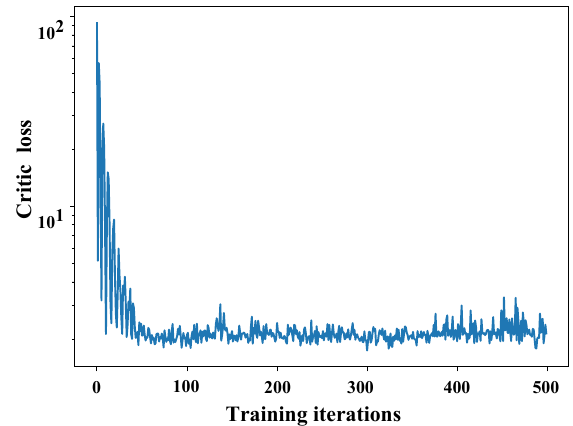
Figure 11. The critic loss over training